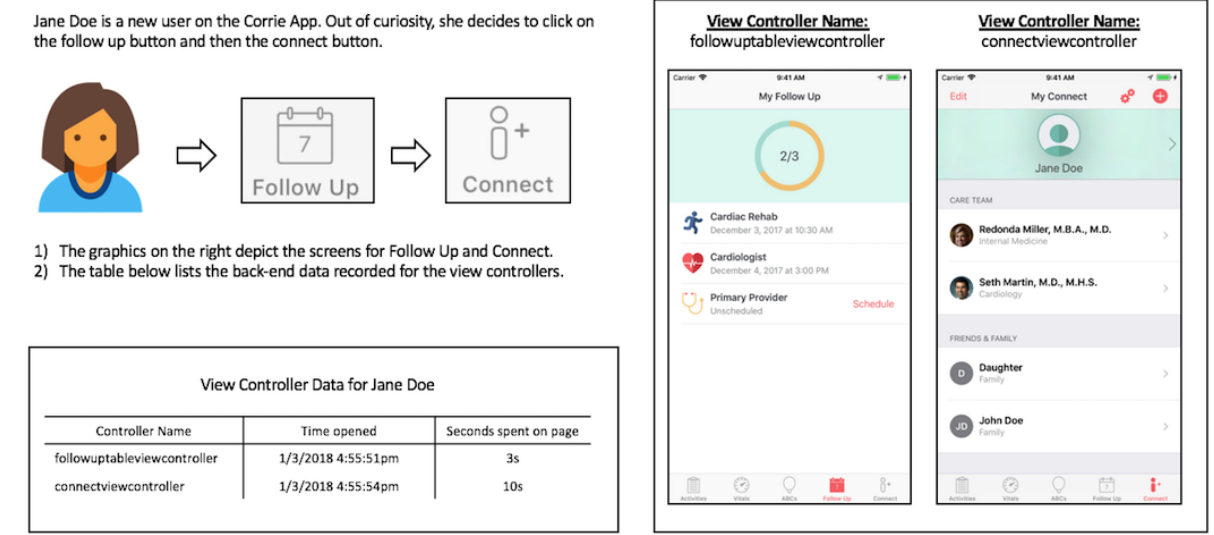
Figure 1. An example of view controllers and their use in user interaction